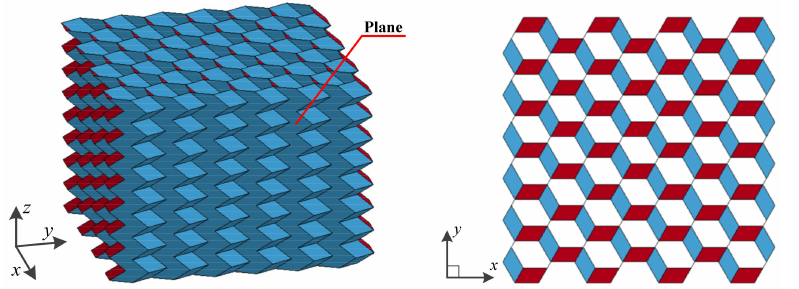
Figure 12. Origami honeycomb with θ = π /3